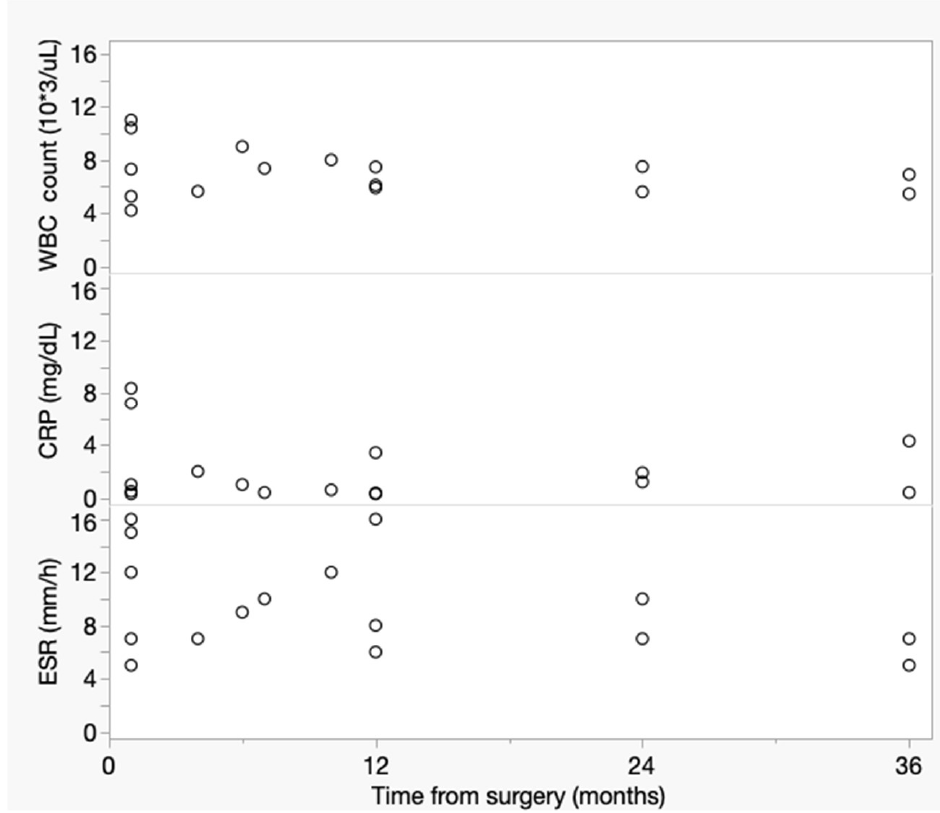
Figure 3. Relationship between WBC count ( ρ = − 0.15; 95% CI: − 0.60 to 0.37; p = 0.57), CRP ( ρ = − 0.07; 95% CI: − 0.54 to 0.44; p = 0.81) and ESR ( ρ = − 0.30; 95% CI: − 0.70 to 0.23; p = 0.26) values and time from EVAR. None of these inflammatory markers was correlated with time elapsed from the endovascular procedure.